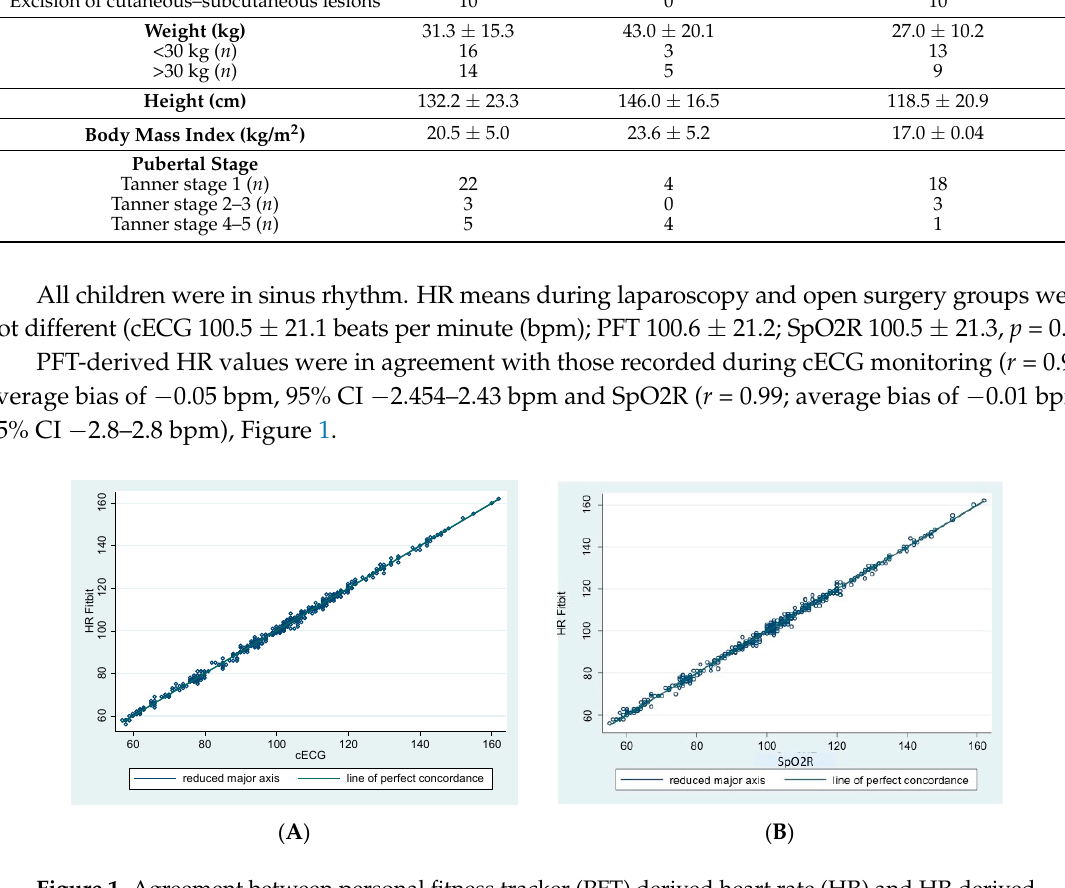
Figure 1. Agreement between personal fitness tracker (PFT) derived heart rate (HR) and HR derived from continuous electrocardiographic monitoring (cECG, Panel A ) and from continuous monitoring with pulse oximetry method (SpO2R, Panel B ).